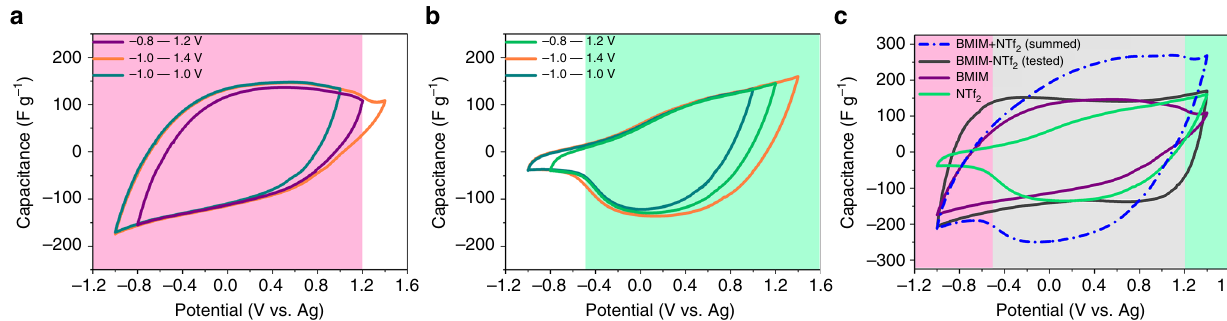
Fig. 5 Electrochemical characterization of sodium alginate-derived activated carbon (SADC) electrode. Cyclic voltammetry (CV) curves in a SiO 2 -IL-BMIM and b SiO 2 -IL-NTf 2 with the same concentration of 0.25 M in propylene carbonate (PC). The curves were scanned within different operating potential windows with the same scan rate of 5 mV s − 1 . c Comparison between the summed and real CV curves of SADC electrode in BMIM-NTf 2 at an operating potential window of − 1.0 to 1.4 V/ref